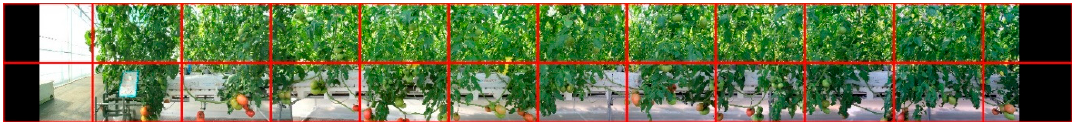
Figure 2. The location of the sub-image in one stitched image of part of the row. Red lines are the outlines of subimages. Table 3. Details of the test dataset.